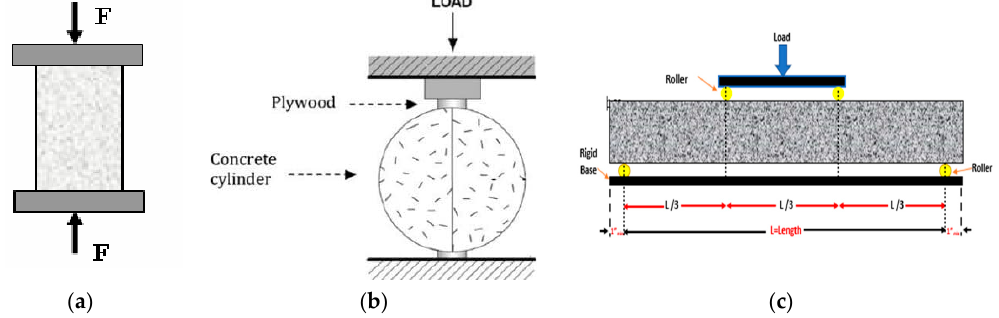
Figure 3. Strength testing machine mechanism ( a ) compressive, ( b ) tensile, ( c ) flexural tests.